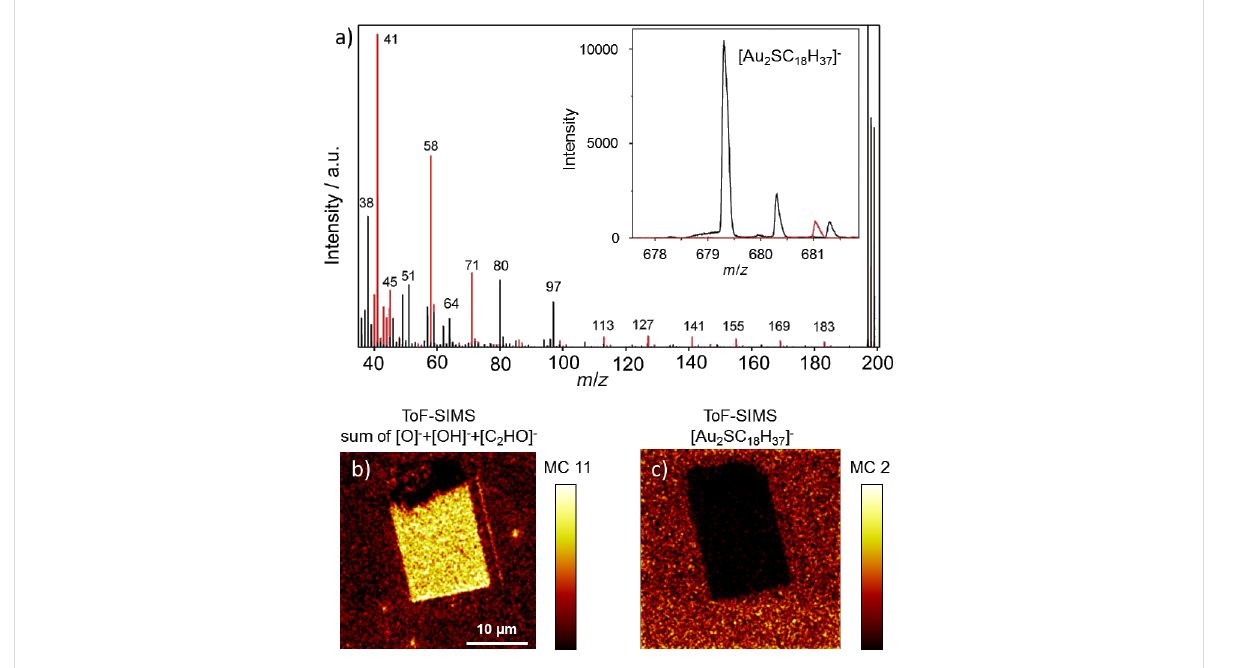
Figure 7: (a) ToF-SIMS spectra of ODT (black) and MHDA (red) SAMs on gold substrates. The inset shows the [Au 2 SC 18 H 37 ] − peak at m / z 679 char- acteristic for ODT. In (b) and (c) the mapping of the [O] − + [OH] − + [C 2 HO] − and the [Au 2 SC 18 H 37 ] − ( m / z 679) fragments, respectively, are shown, demonstrating the successful grafting of MHDA into the ODT